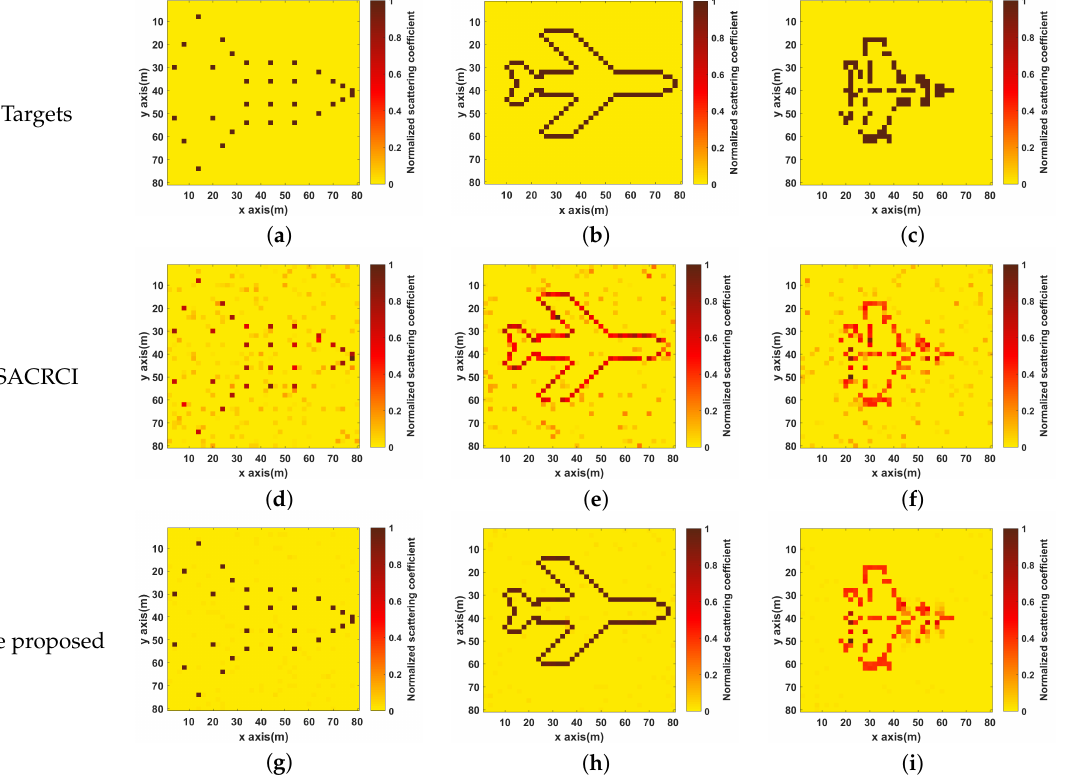
Figure 13. Imaging results for different target scenes ( a – c ) Three different target scenes; ( d – f ) Imaging results of SACRCI; ( g – i ) Imaging results of the proposed